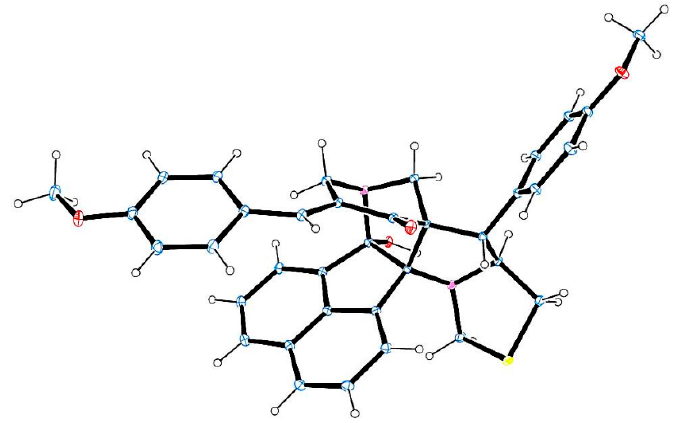
Figure 1. Oak Ridge Thermal Ellipsoid Plot (ORTEP) diagram of 4j .